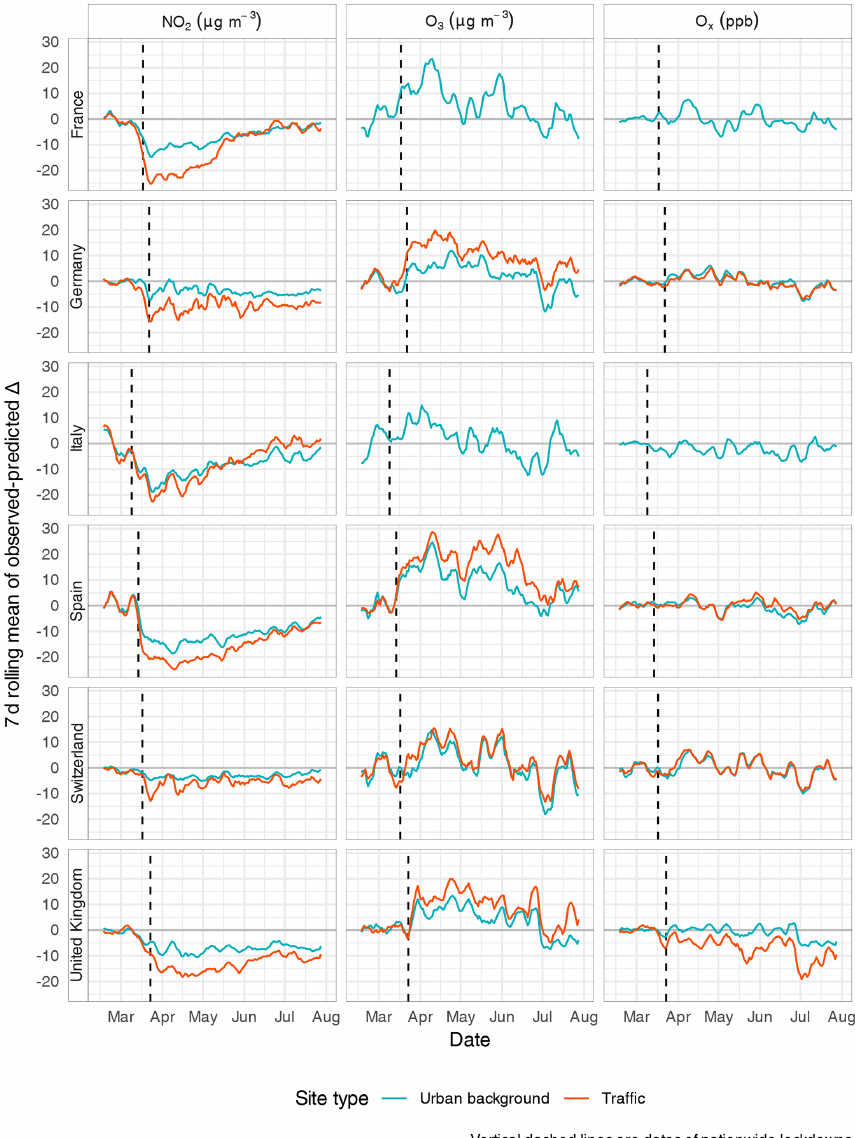
Figure 6. The 7d rolling means of the observed-predicted concentrations’ deltas for NO 2 , O 3 , and O x for six selected countries in Europe between 14 February and 31 July